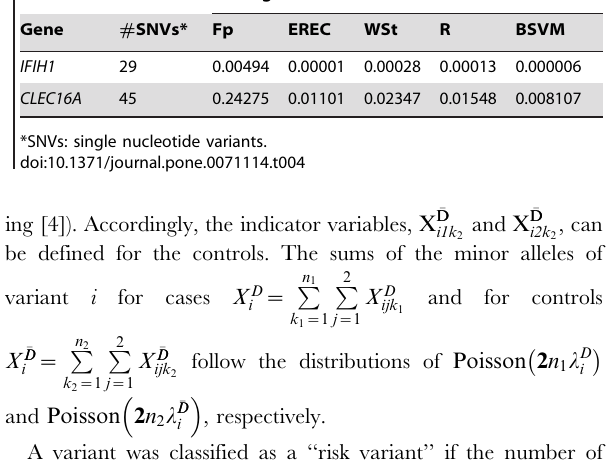
Average P-value